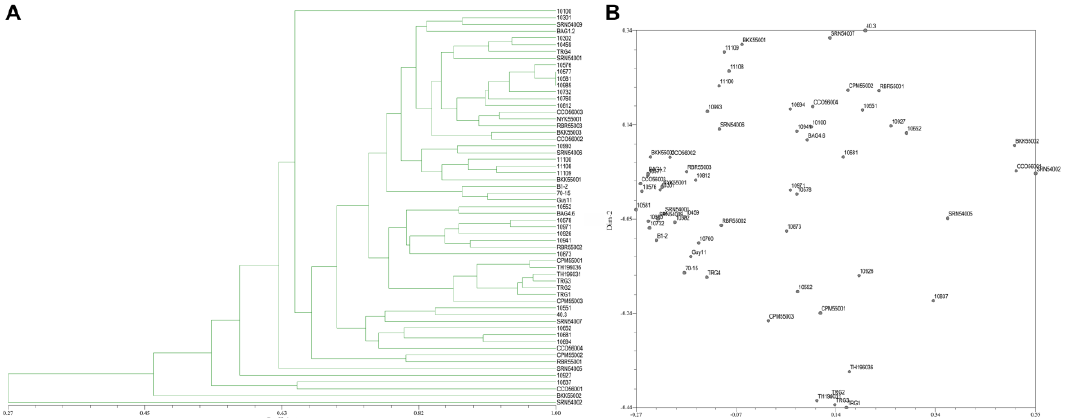
Figure 5. ( A ), Dendrogram presenting the relationship from ISSR markers based on unweighted pair-group method with arithmetic means (UPGMA) cluster analysis. ( B ), 2D principal component analysis (PCA) based on genetic relationships from ISSR data using the DECENTER and EIGEN features of NTSYSpc.